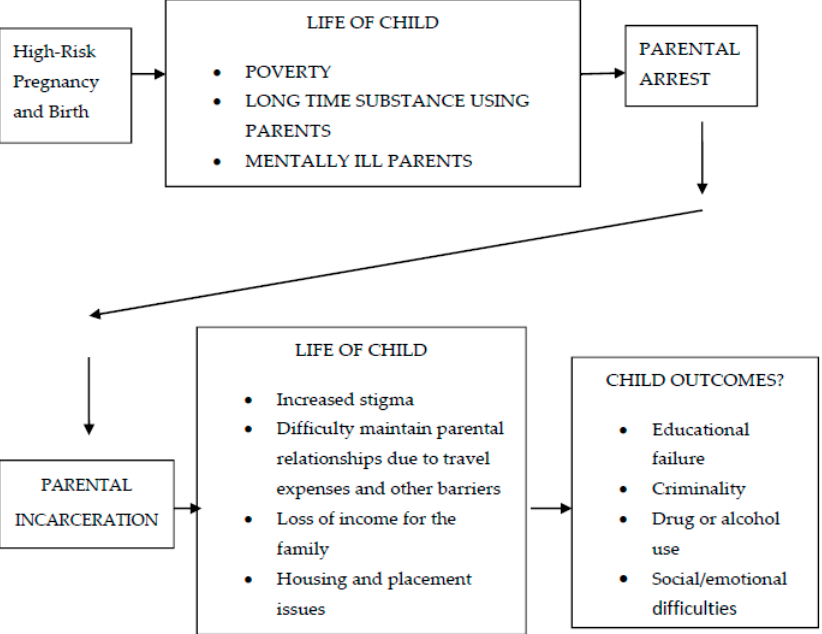
Figure 1. A Multiple Risk Model—poverty, parental substance use, parental mental illness, and parental